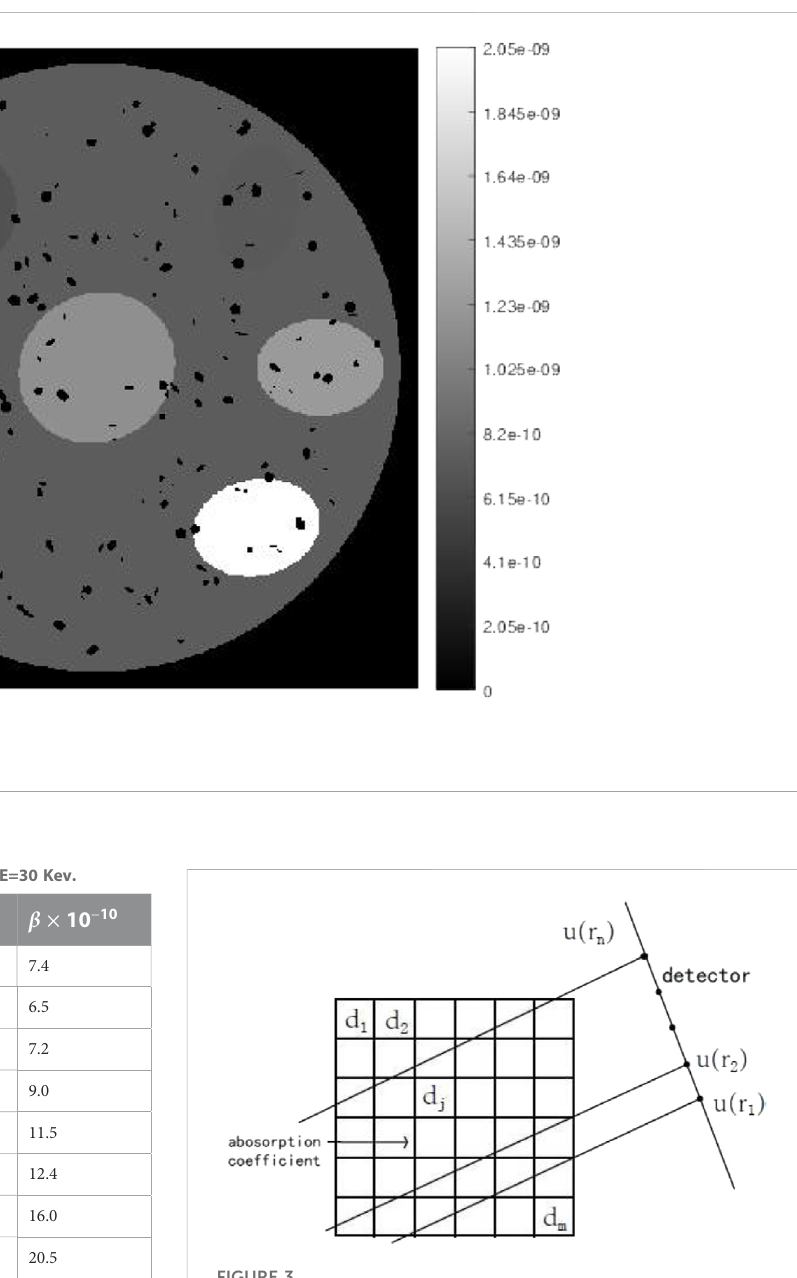
FIGURE 3 Acquisition